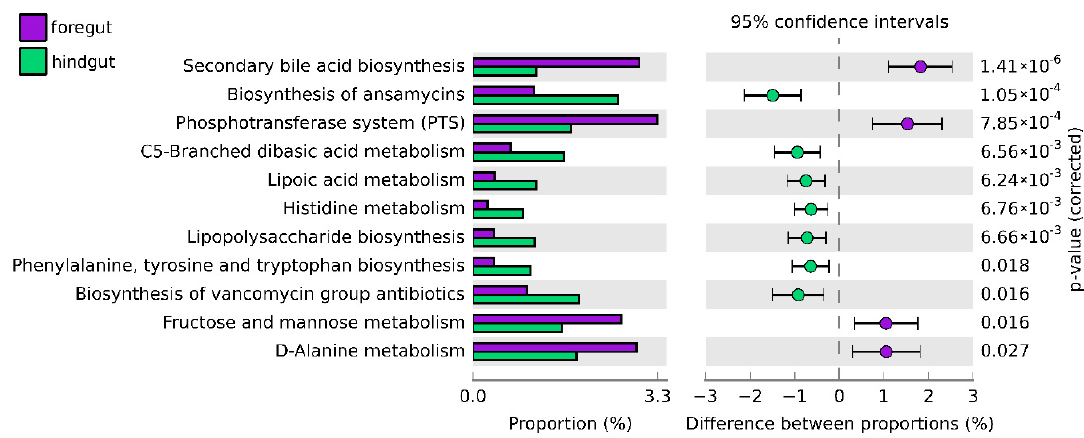
Figure 8. The significant differences in relative abundance of predicted gene proportion between the foregut and hindgut of Xylocopa tenuiscapa .